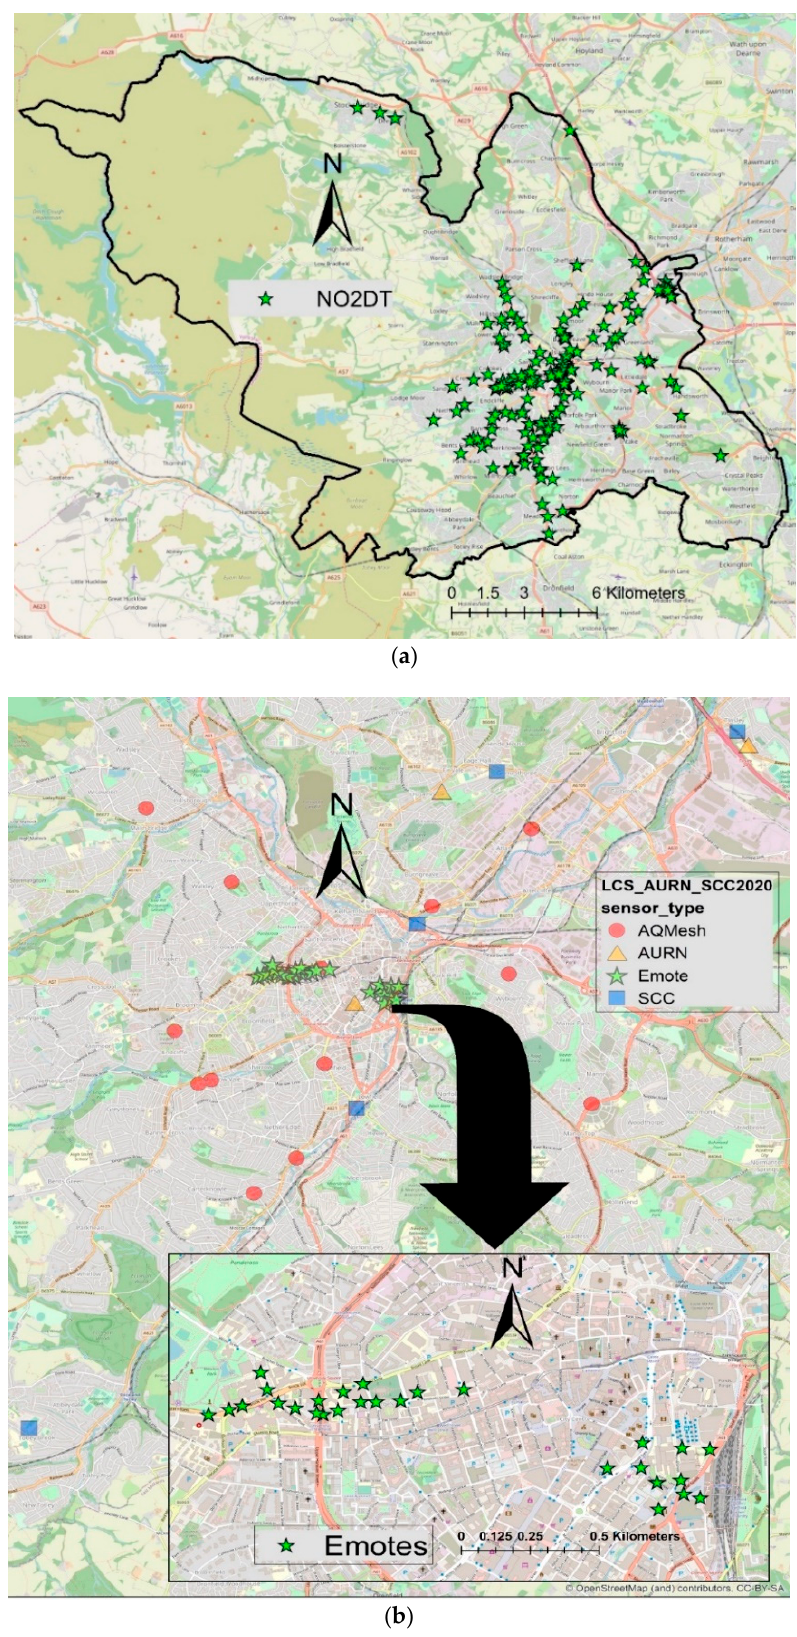
Figure 1. Showing the locations of DT, LCS (both AQMesh pods and Envirowatch E-MOTEs), AURN and SCC monitoring sites in Sheffield: ( a ) DT locations; ( b ) AURN, SCC and LCS locations.